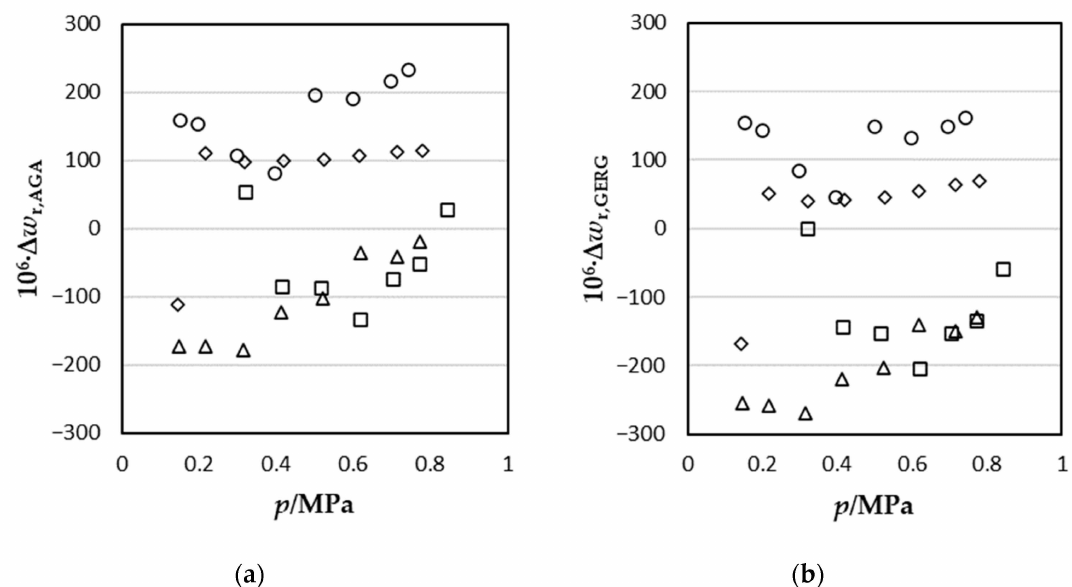
Figure 2. Relative deviations of the speed of sound ( ∆ w r,EoS = ( w exp − w EoS )/ w EoS ) from the values predicted by equations of state as a function of pressure: ( a ) AGA8-DC92 and ( b ) GERG-2008. Each mixture and isotherm are represented with a different symbol: ( ) raw biogas at T = 300 K; ( ♦ ) washed (cid:35) biogas at T = 273 K; ( ∆ ) washed biogas at T = 325 K; ( (cid:3) ) biomethane at T = 325